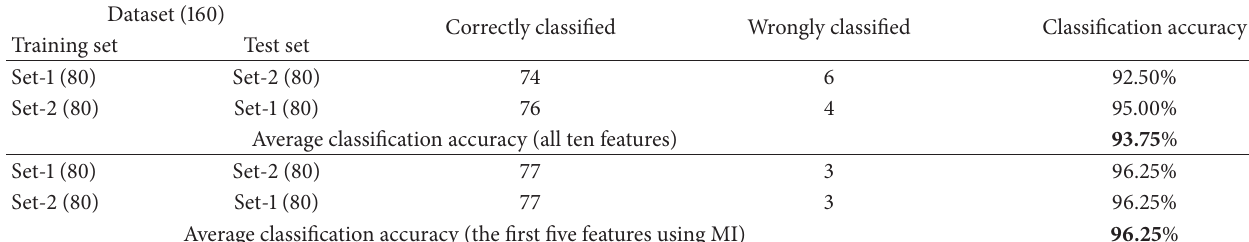
Table 6: The second-fold test accuracy of the proposed